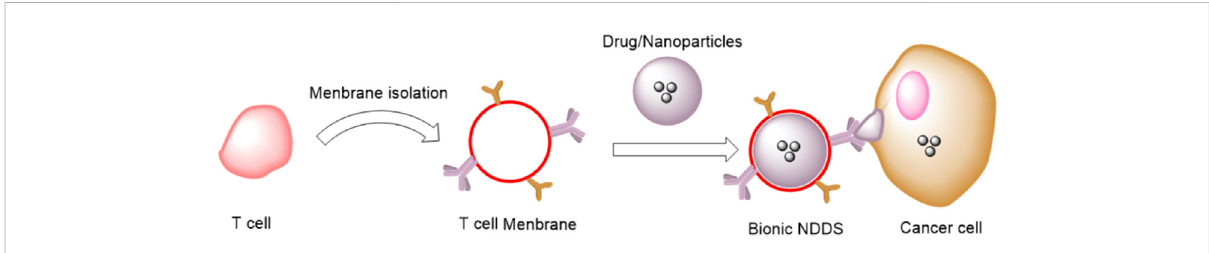
FIGURE 3 NDDS based on T cell membrane camou fl age for immunotherapy.